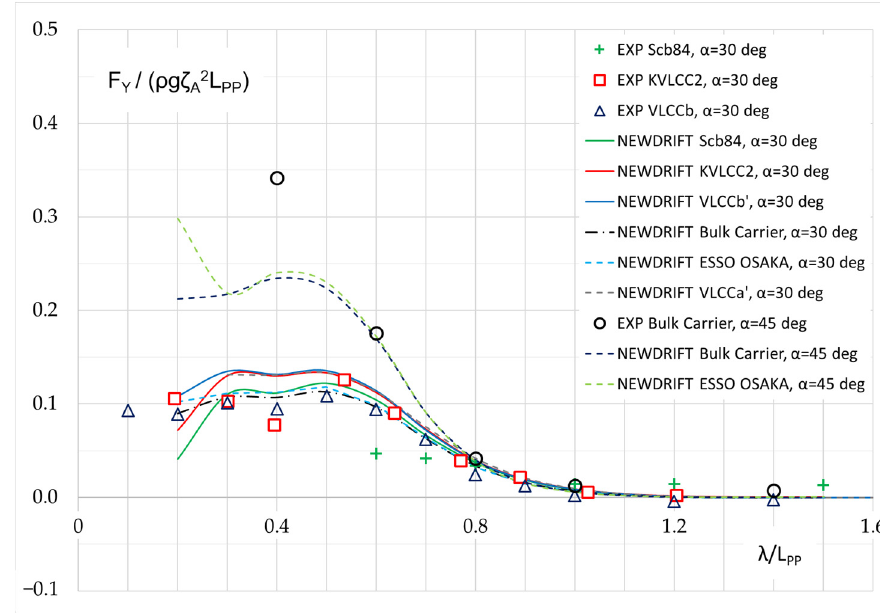
Figure 4. Mean sway force of several ships in regular stern waves at zero speed.